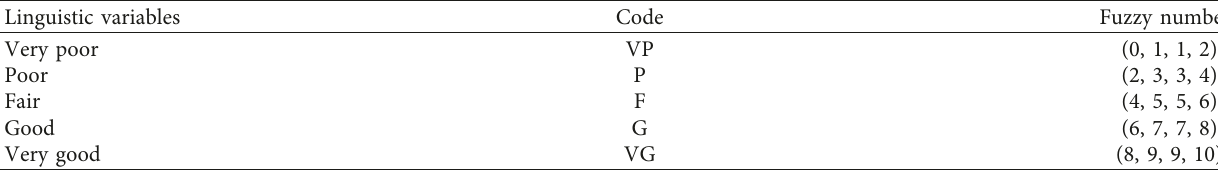
Table 7: Grade scale of performance assessment [3]. Linguistic variables Code